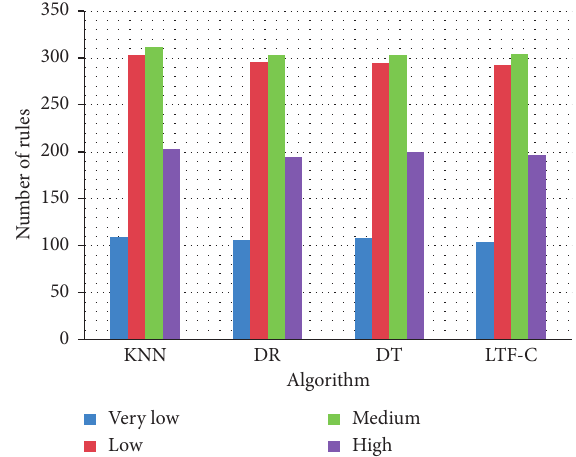
Figure 4: Algorithms along with the number of rules for the given decision